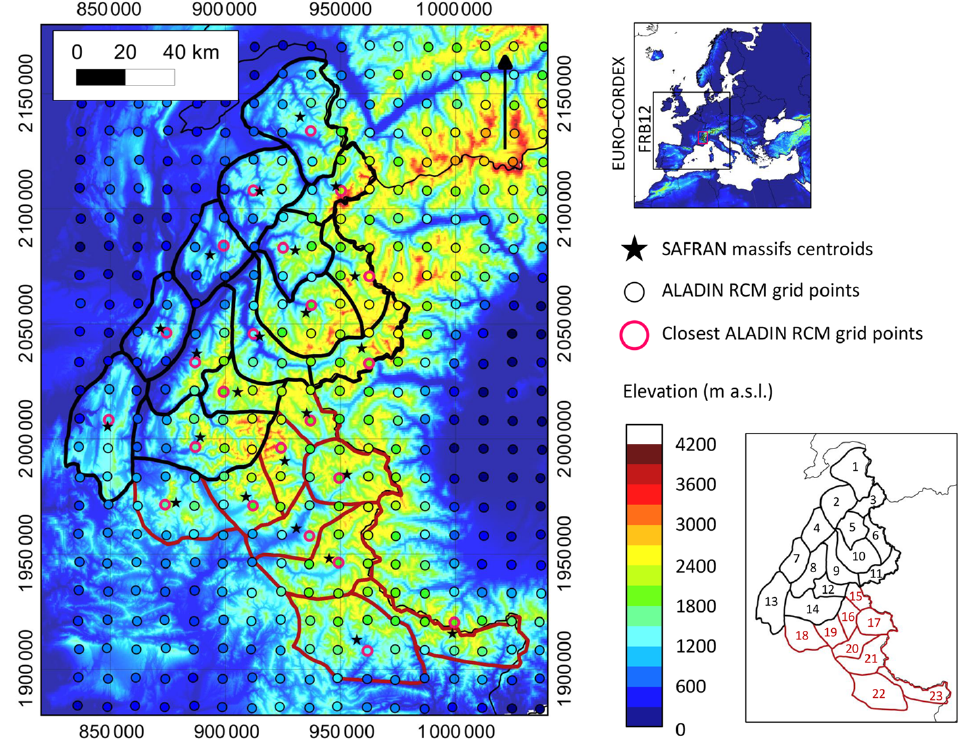
Figure 3. Description of geographical configuration of the SAFRAN reanalysis and the ALADIN RCM. The top right panel illustrates the spatial domains covered by the simulation (FRB12) and by EURO-CORDEX, and the location of the study area is indicated by the pink box. In the left panel, SAFRAN massifs are delimited by the black contours for the northern Alps and by the burgundy contours for the southern Alps, and their centre points are indicated by the black stars. ALADIN grid points are represented by circles, with pink circles for the grid points closest to each SAFRAN massif centre point. Surface elevation in France is from the 50m DEM from the Institut National d’Information Géographique et Forestière (IGN) and outside France from GTOPO30 (resolution of 30arcsec ≈ 1km). The elevation of ALADIN grid points is indicated by the colour palette (in ma.s.l.). The bottom right panel indicates the location of each massif used in Table 3. Projection is in Lambert II étendu